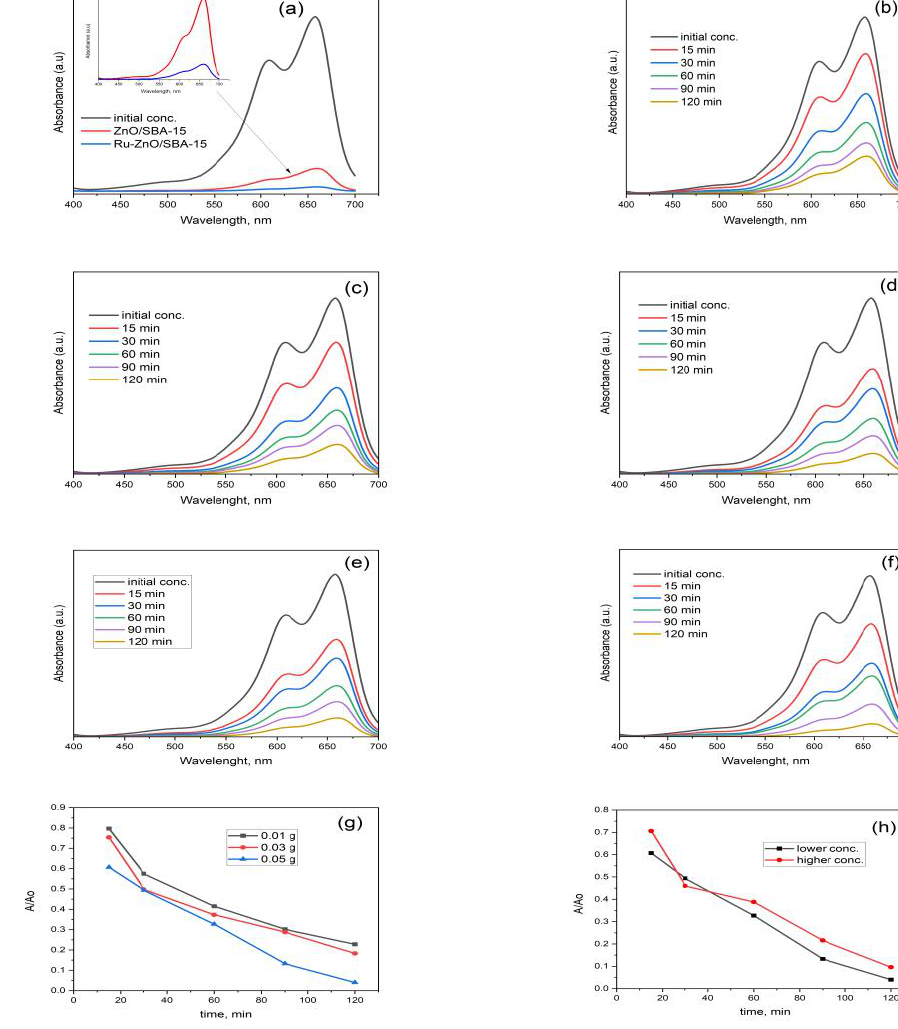
Figure 6. Absorbance data of MB removal for: Comparison between ZnO/SBA-15 and Ru-ZnO/SBA- 15 composites ( a ); Ru-ZnO/SBA-15 at 0.01 g ( b ); 0.03 g ( c ); 0.05 g ( d ); initial MB conc. of 20 ppm ( e ) 35 ppm ( f ); photocatalytic degradation of MB in the presence of catalyst dosage ( g ); initial concen- tration of the pollutant ( h ).